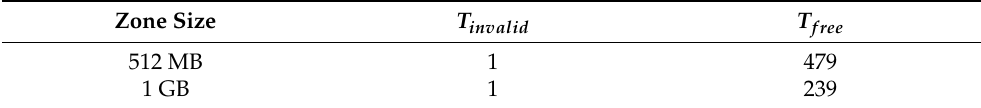
Table 2. Configured free zone and invalid zone thresholds according to zone size. Zone Size T invalid 512